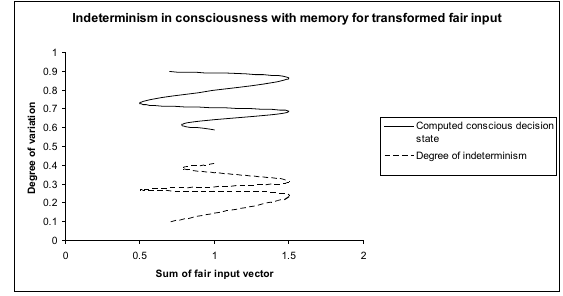
Fig. 23. Variation consciousness in system with transformed excitation (fair C2).